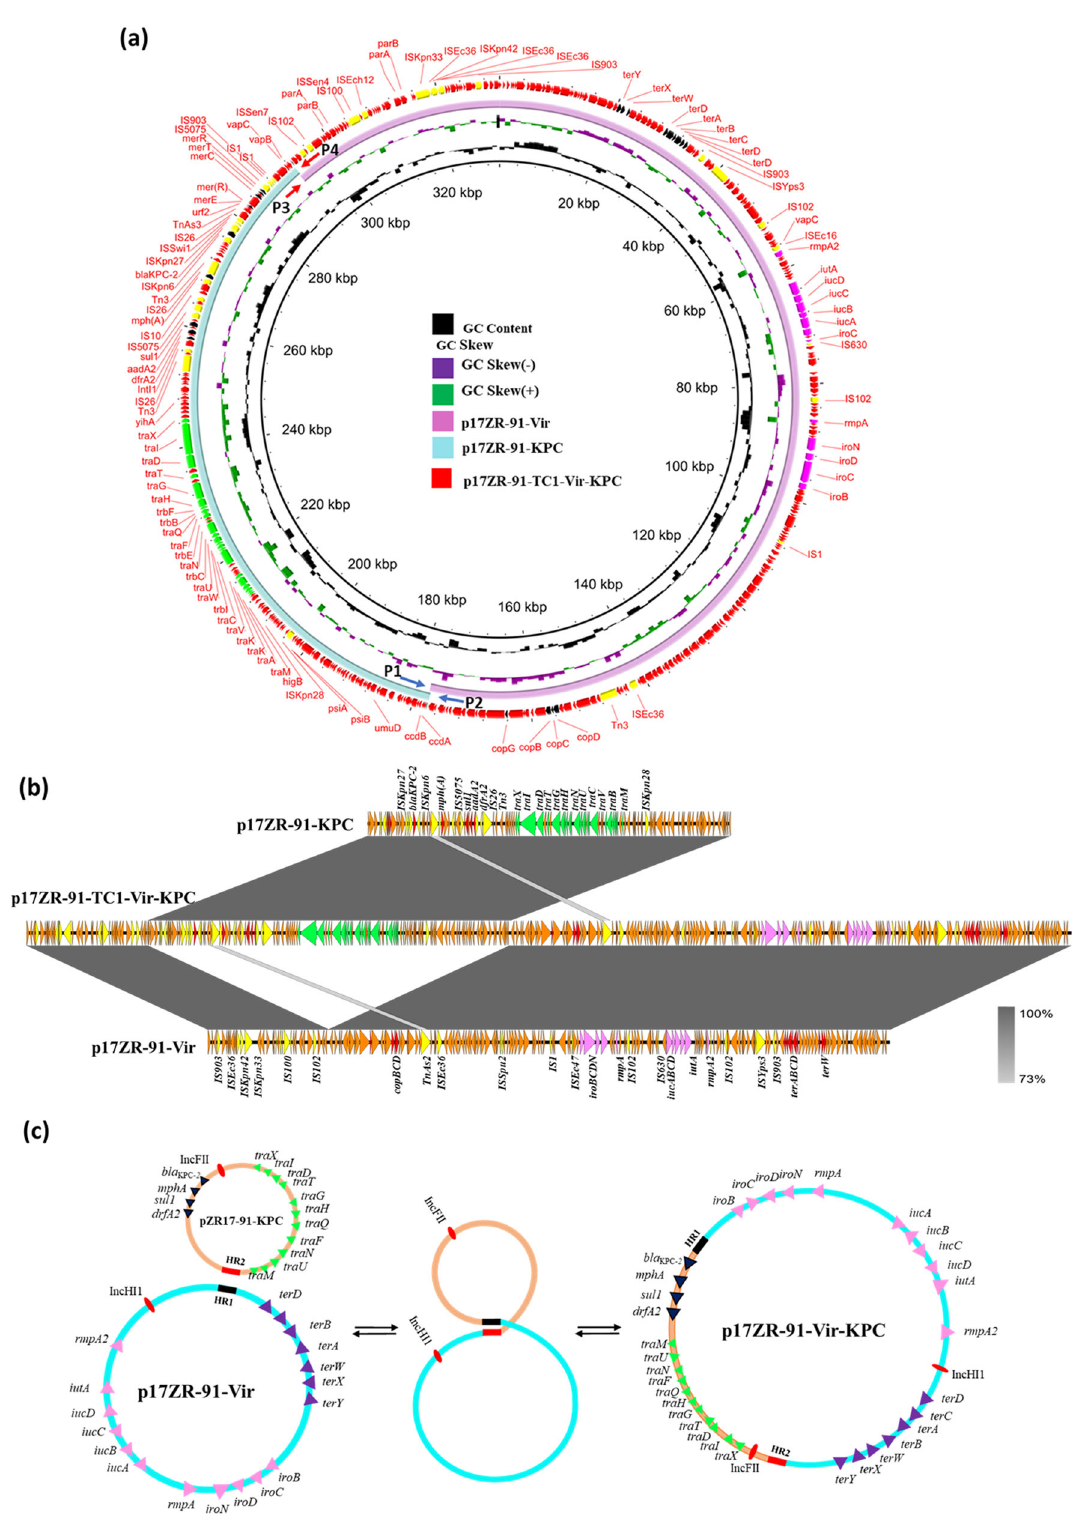
Fig. 3 Formation of conjugative fusion virulence plasmid p17ZR-91-Vir-KPC. Alignment of virulence plasmid p17ZR-91-Vir and bla KPC-2 -bearing plasmid p17ZR-91-KPC with fusion plasmid p17ZR-91-Vir-KPC recovered from K. pneumoniae 17ZR-91 using BRIG ( a ) and Easy fi g ( b ). c Potential mechanism of plasmid fusion through homologous recombination. Two plasmids were integrated at the HR region (HR1, black and HR2, red) and underwent homologous recombination, resulting in a fusion